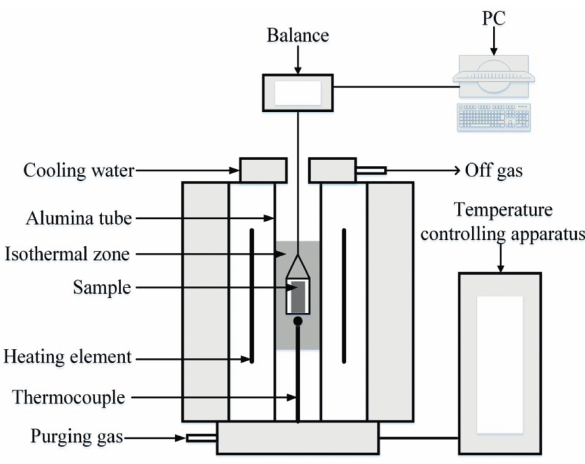
Figure 1: Schematic diagram showing the programmable reduction